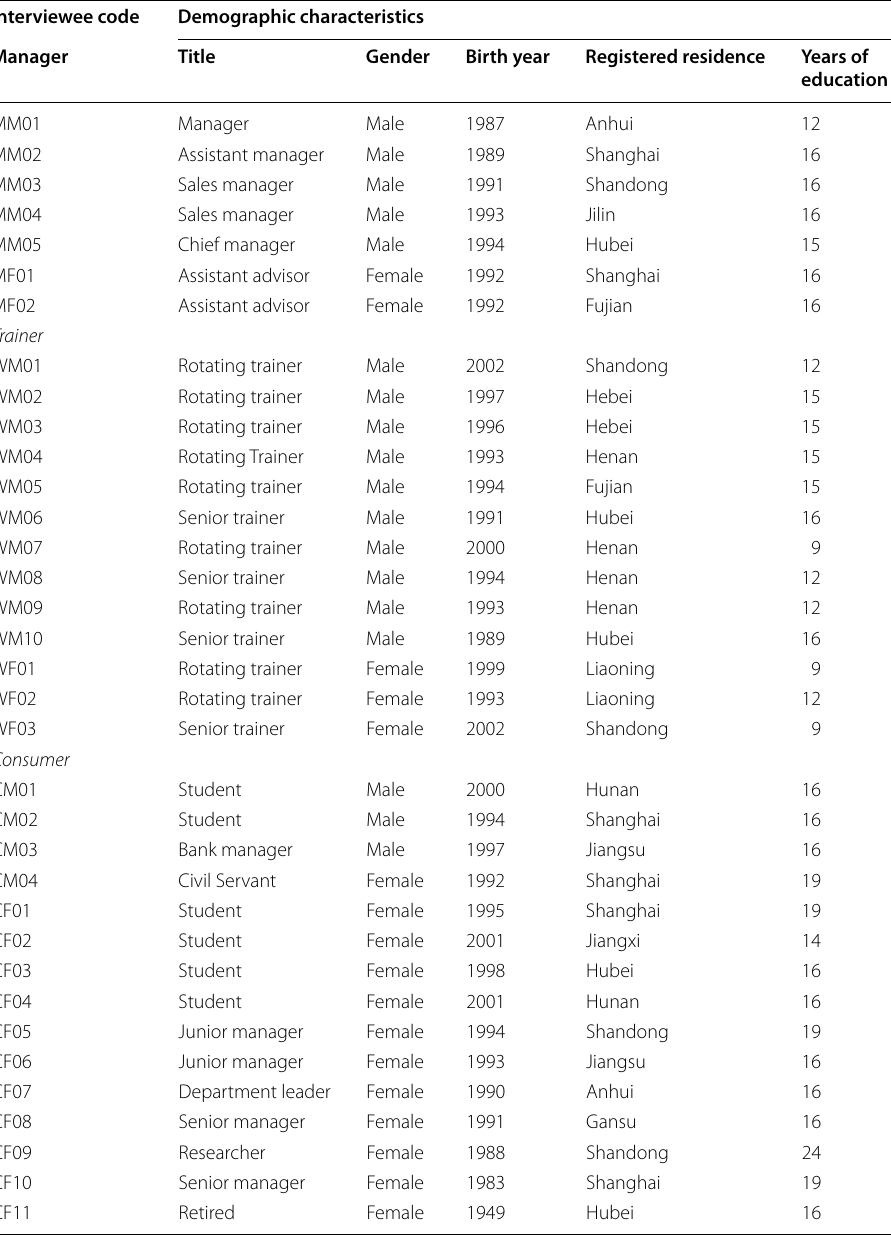
Table 2 Summary of demographic profiles of the interviewees Interviewee code Demographic